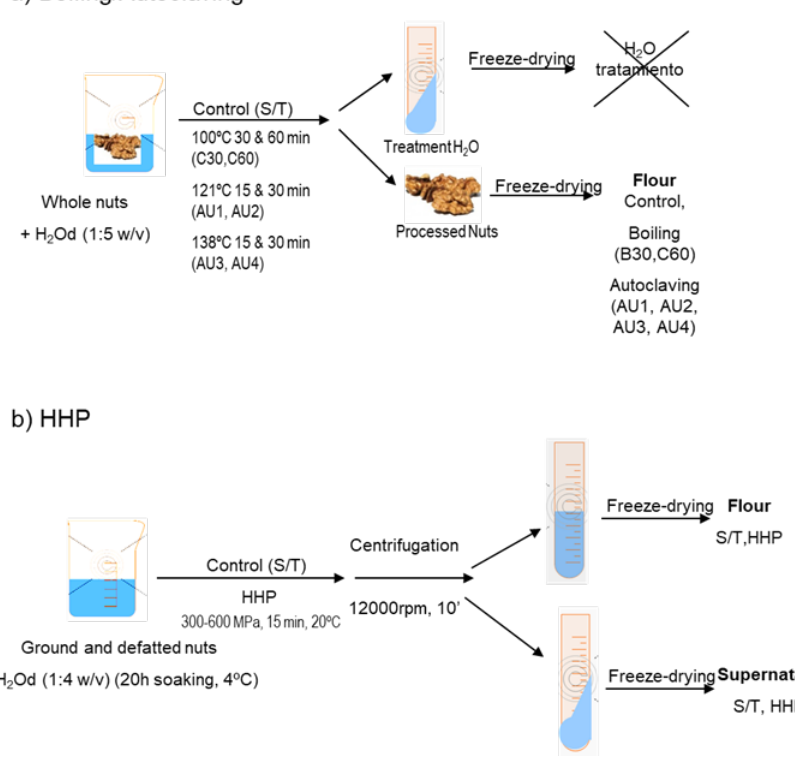
Figure 7. Scheme of ( a ) boiling and autoclave treatments and ( b ) high hydrostatic pressure (HHP) treatment of tree nut samples.